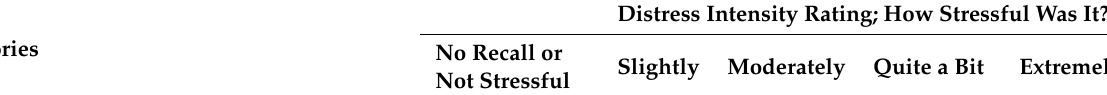
Table A1. Checklist of stressful